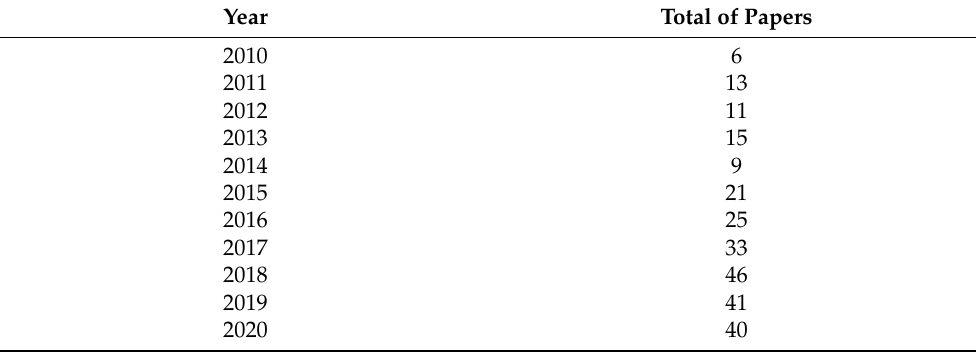
Table 3. Total Number of papers collected per